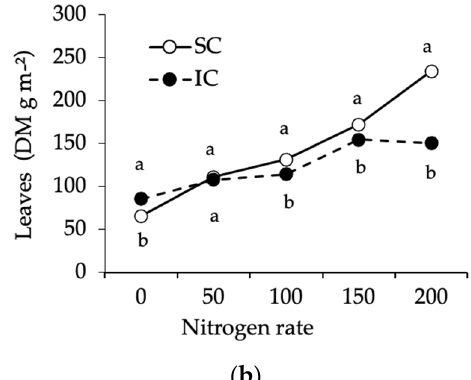
Figure 2. Year x cropping system interaction effect on ( a ) forage production and ( b ) grain production. Values are means of two harvesting stages, five N rates, and three replicates. Vertical lines represent HSD and values with the same letter are not statistically different for p ≤ 0.05. B-SC: barley sole crop; F-SC: field bean sole crop; IC: intercrop.